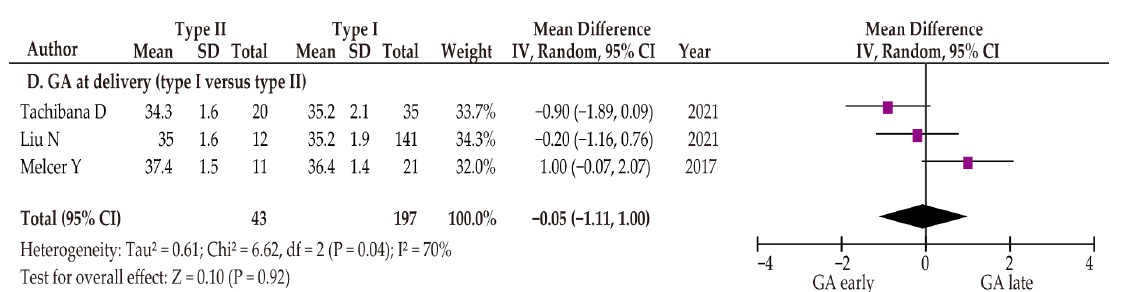
Figure 2. Meta analysis of the characteristics and outcomes of type I and type II vasa previa. The pooled odds ratios for ( A ) the rate of ART (unadjusted), ( B ) the rate of antenatal diagnosis (unad- justed), ( C ) the rate of emergent cesarean delivery (unadjusted), and ( D ) gestational age at delivery between women with type I and type II vasa previa are shown. Forest plots were ordered by the year of publication and relative weight (%) of the study within the strata. The heterogeneity among the studies in each analysis was as follows: substantial heterogeneity ( A : I 2 = 64%) in the unadjusted analysis, no heterogeneity ( B : I 2 = 0%) in the unadjusted analysis, low heterogeneity ( C : I 2 = 23%) in the unadjusted analysis, and substantial heterogeneity ( D : I 2 = 70%) in the unadjusted analysis. The above results were calculated using RevMan ver. 5.4.1 and may differ slightly from the original values. Abbreviations: CI, confidence interval; ART, assisted reproductive technology; Emergent CD, emergent cesarean delivery; GA, gestational age.